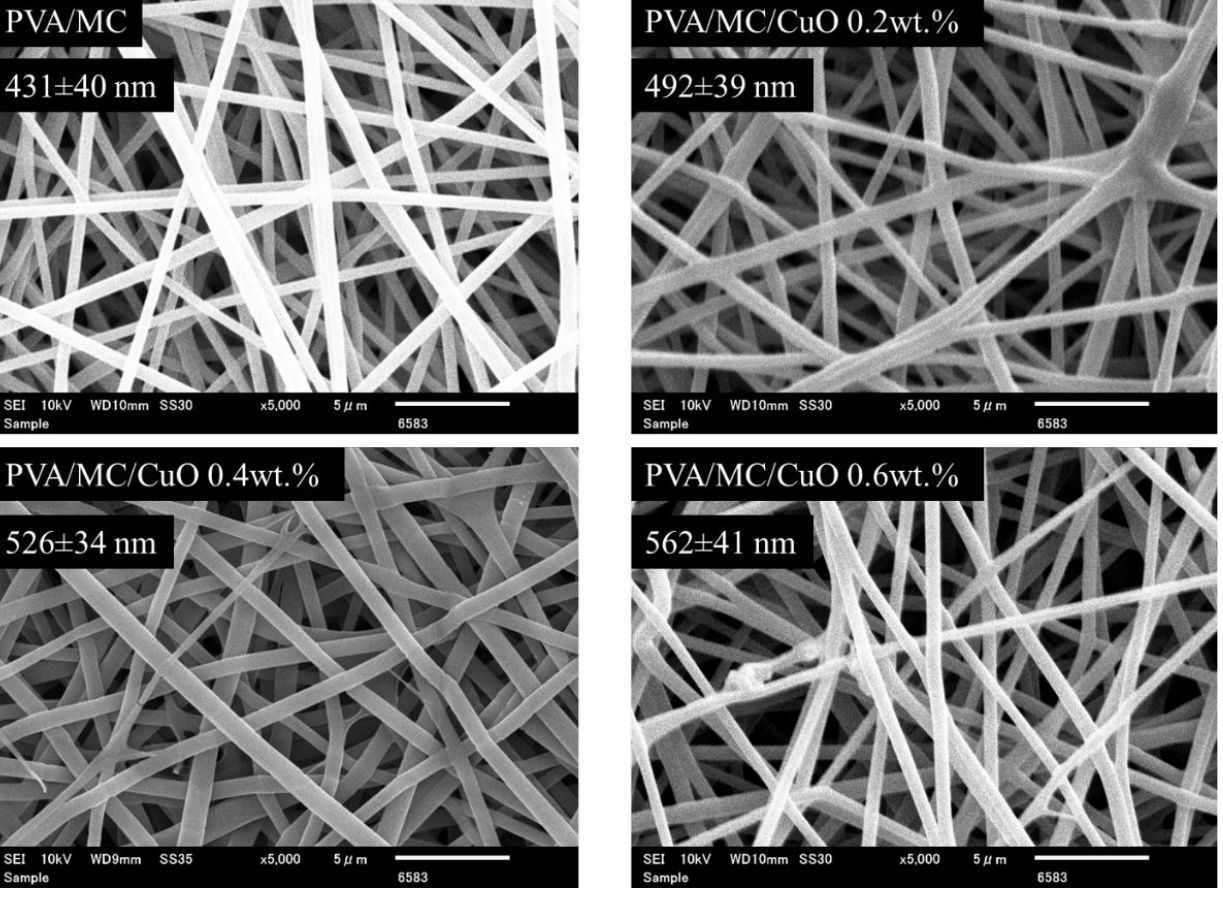
Figure 1. SEM images of PVA/MC, PVA/MC/CuO 0.2 wt.%, PVA/MC/CuO 0.4 wt.%, and PVA/MC/CuO 0.6 wt.% nanofibers .